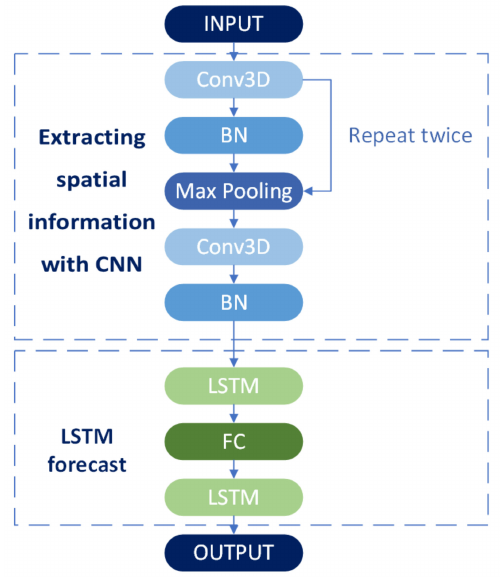
Figure A3. CNN-LSTM hybrid model